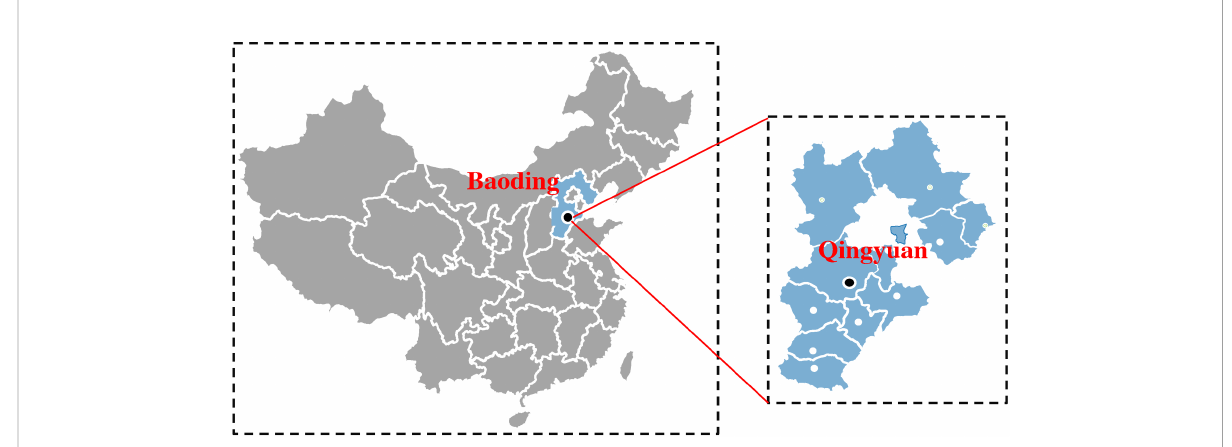
FIGURE 1 A sampling plot in Qingyuan District, Baoding, Hebei province. The red dot represents the sampling